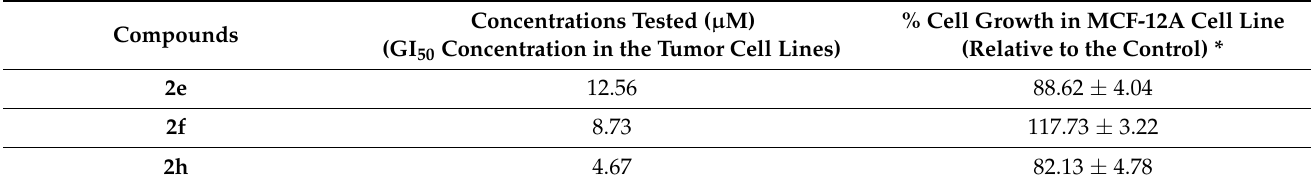
* Values correspond to the mean ± S.E.M. of at least three independent experiments, all performed in duplicate. The % of growth of the cell line MCF-12A was determined using the GI 50 concentrations of each compound, in the most sensitive tumor cell lines previously determined (Table 2).